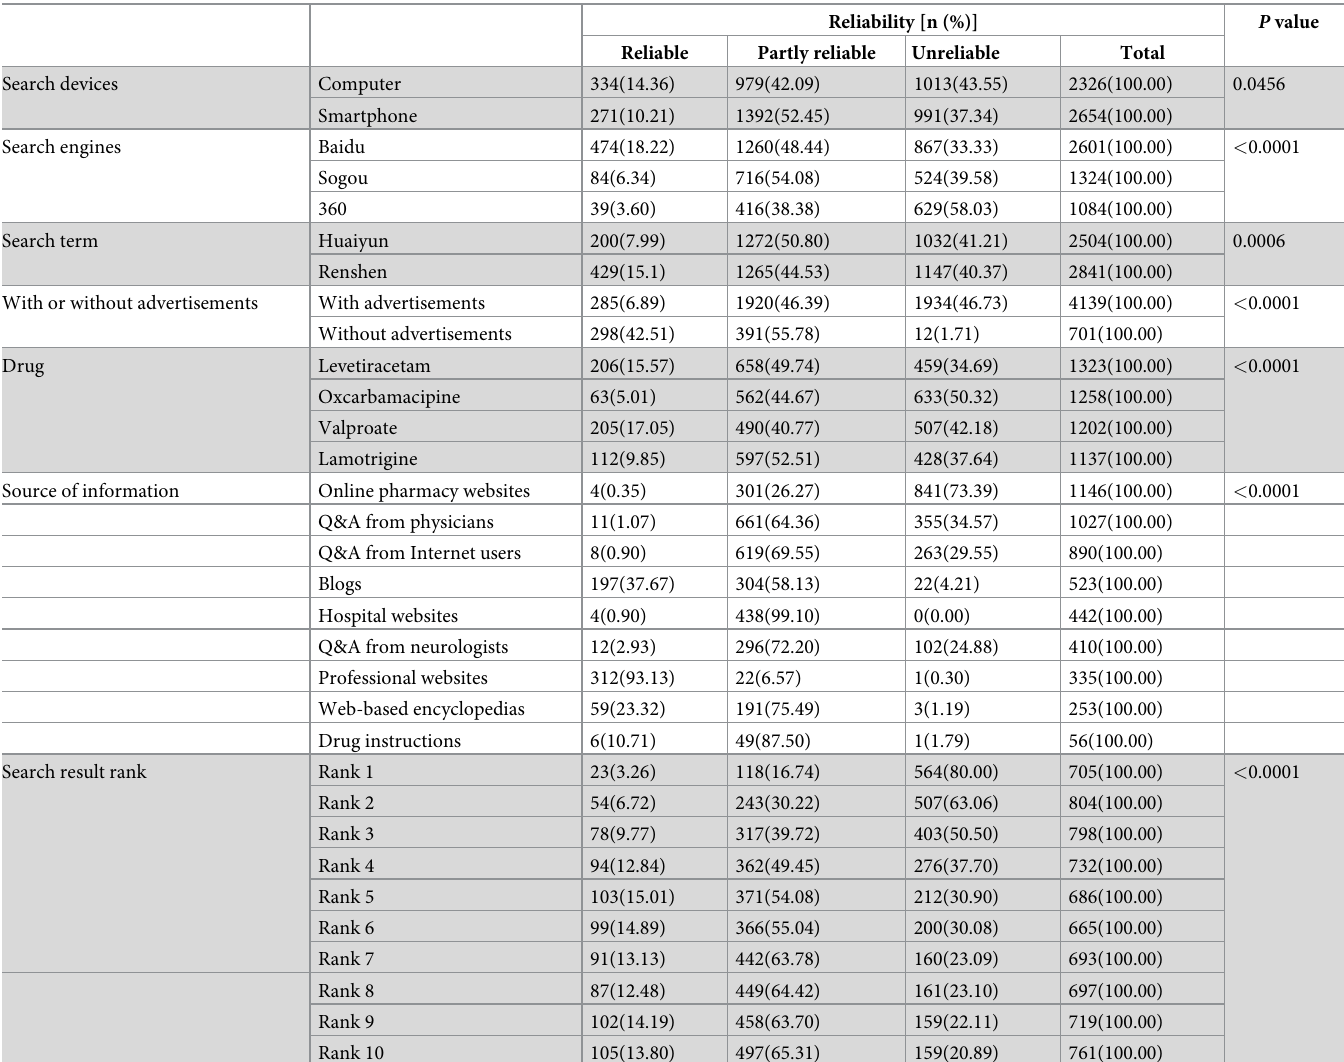
Table 2. Univariate analysis of reliability in different